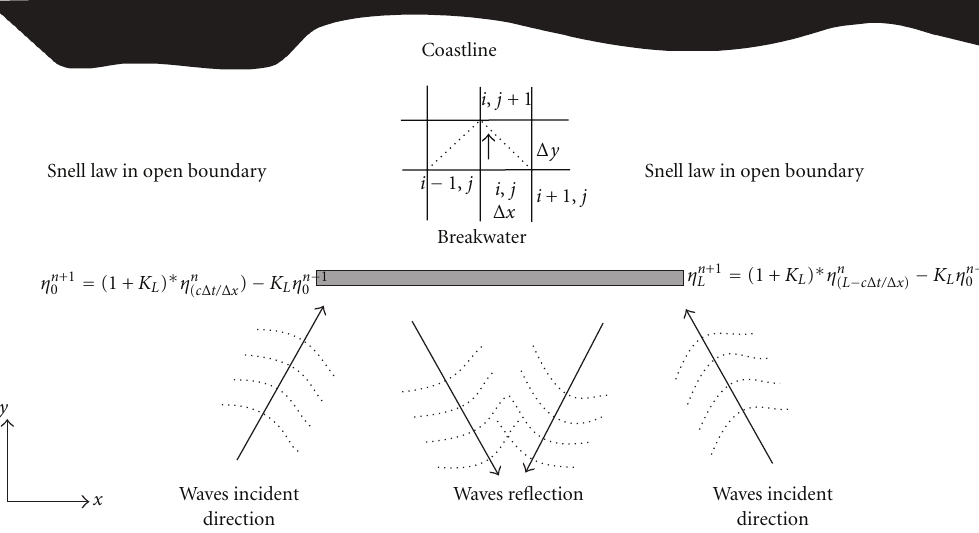
Figure 4: Boundary conditions used in the open domain and near of the breakwater.